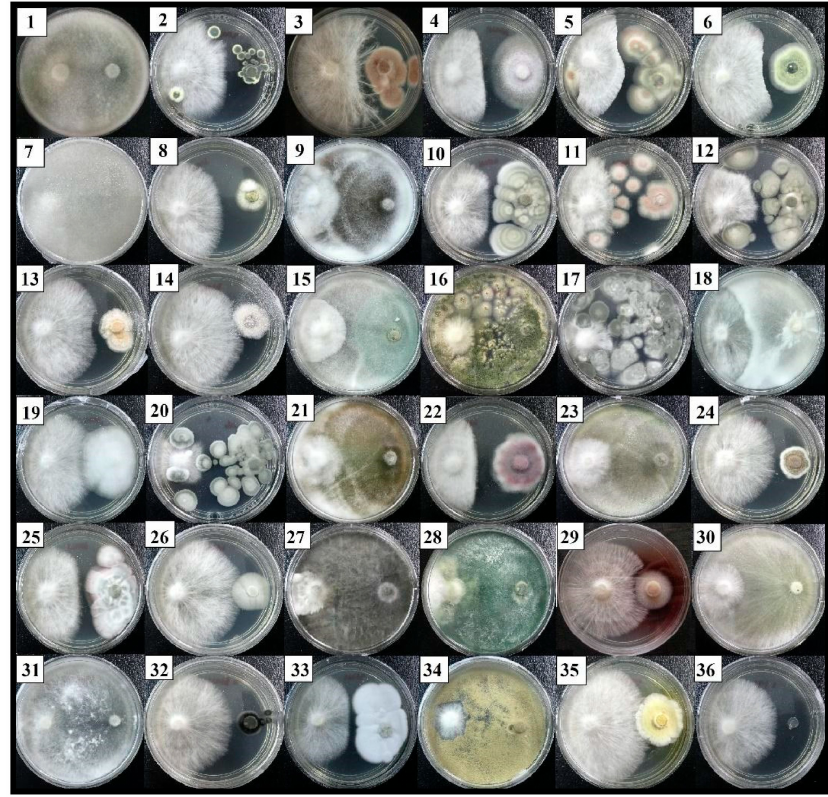
Figure 1. Interaction between Rigidoporus microporus ( left ) and 35 isolates of soil-borne fungi ( right ) after 5 days of dual culture in Petri dishes with the potato dextrose agar. See Table 4 for the fungal– number